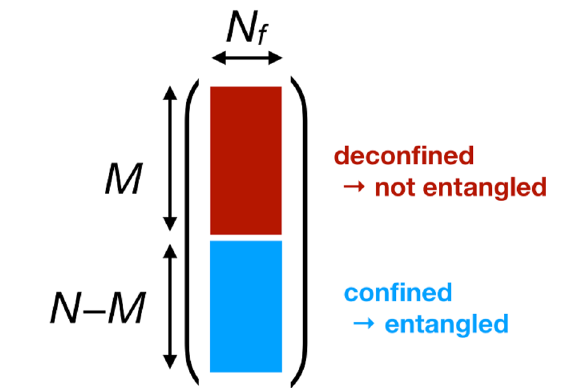
Figure 12 . Partial deconfinement phase in the vector model, at small but finite deformation parameter C + (cid:28) 1 . The deconfined sectors in the left and right Hilbert spaces are not entangled, while the confined sectors are